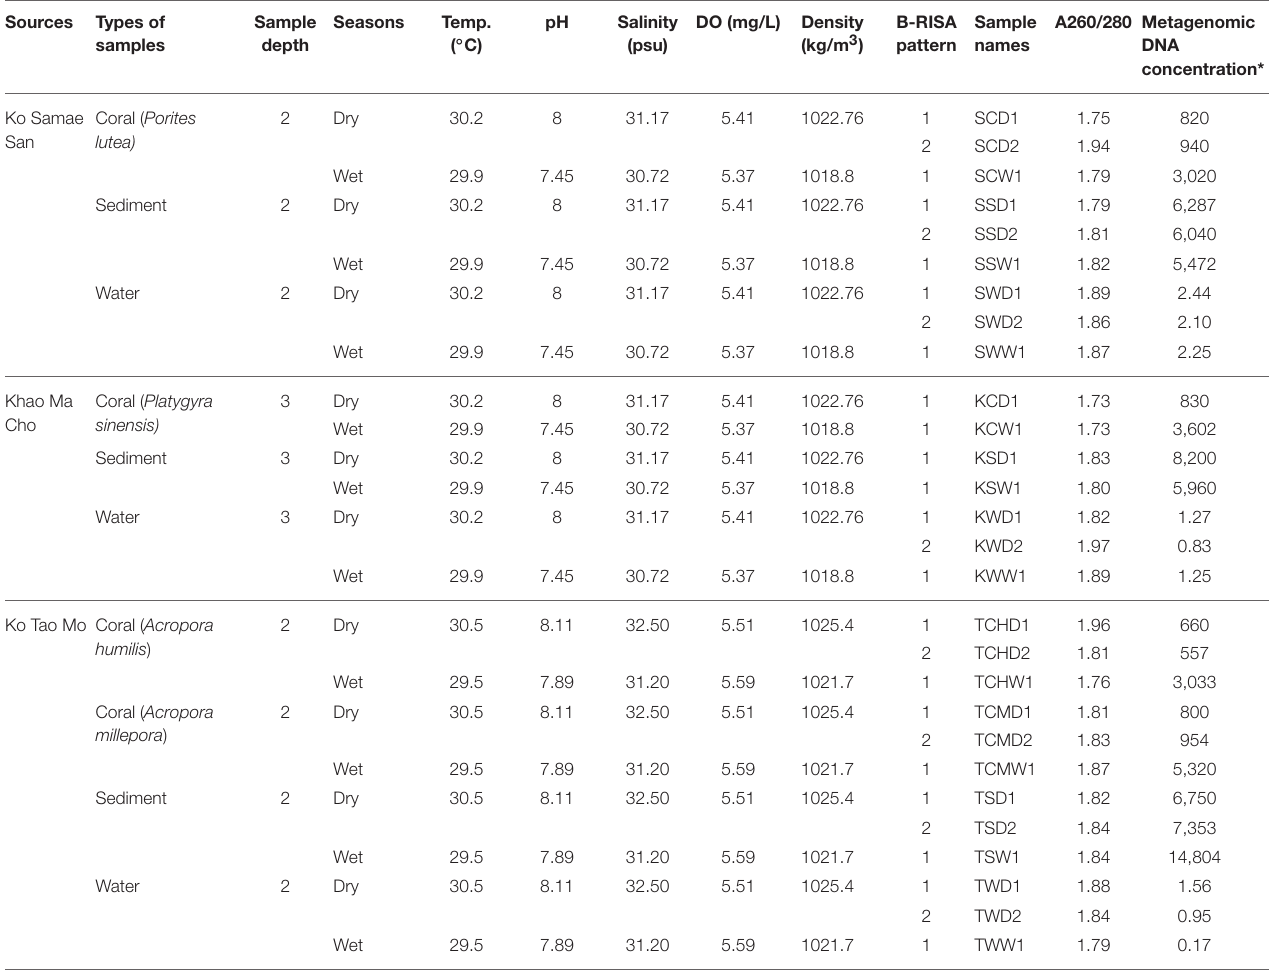
TABLE 1 | Locations, water physical properties, and metagenomic DNA of sample collections. Sources Types of